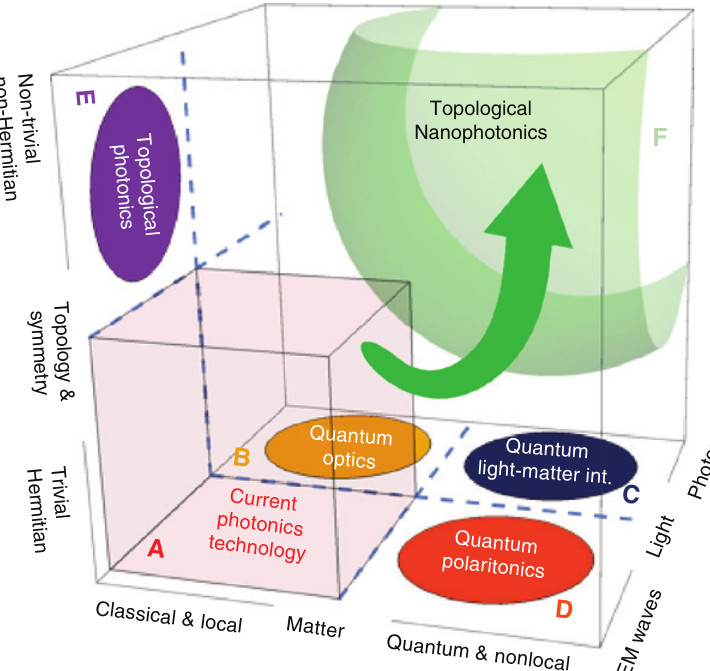
Figure 1: Rooted in classical electrodynamics, current photonics (A) constitutes key enabling technology (fiber-optics, lasers, detectors, integrated photonics, etc.), being critical to Information and Communications technology. Emerging quantum technologies harvest from quantum phenomena of both light (B) and matter (D), and combined light-matter aspects [8, 9] (C), while there is growing attention to classical electrodynamics in systems comprising non-trivial topologies and symmetries [7] (E). Developments in topological nanophotonics will enable explorations of the virgin territory (F) hosting intriguing interplays of light, matter, topology, and